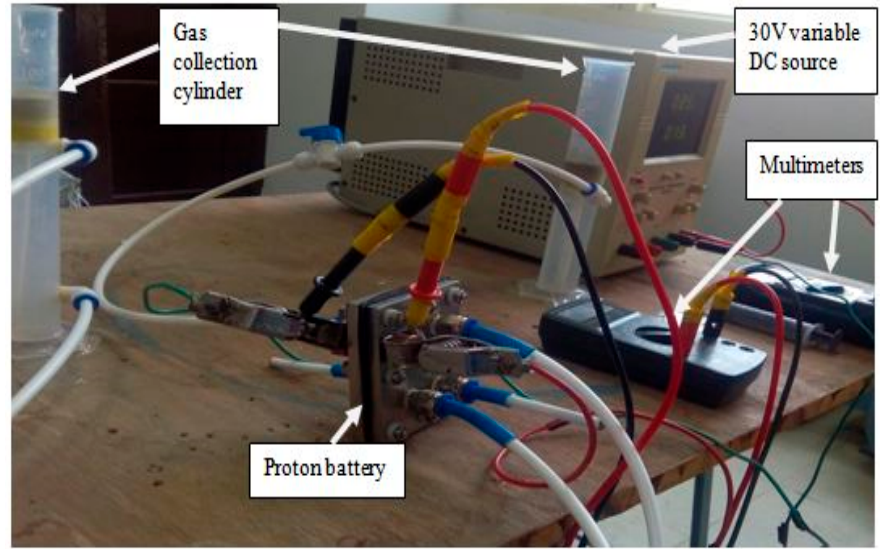
Figure 10. Experimental setup of proton battery or modified unitized regenerative fuel cell URFC.